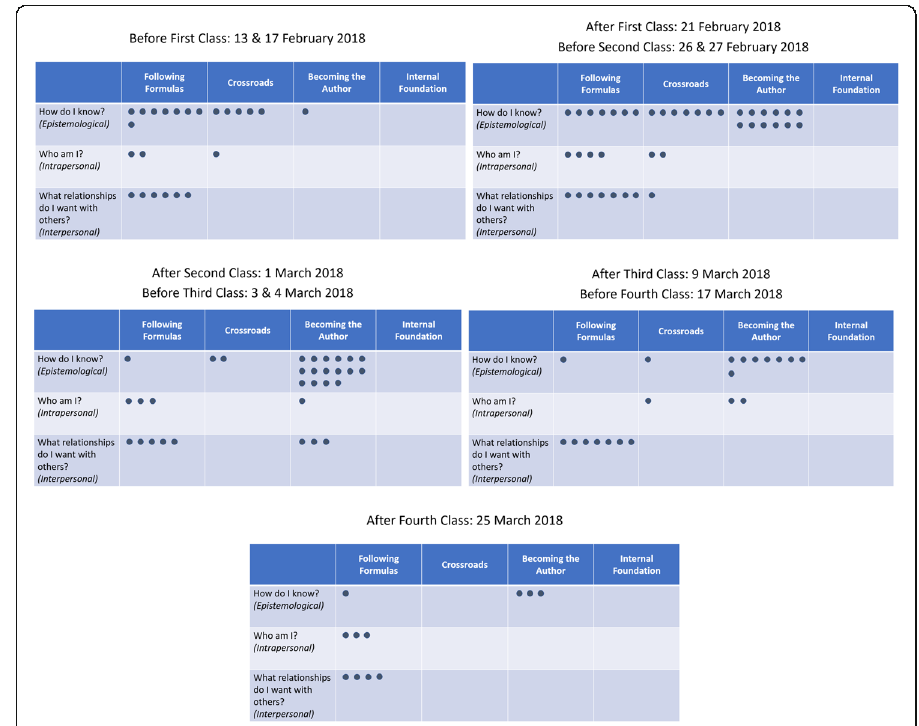
Fig. 2 Visualization of codings in